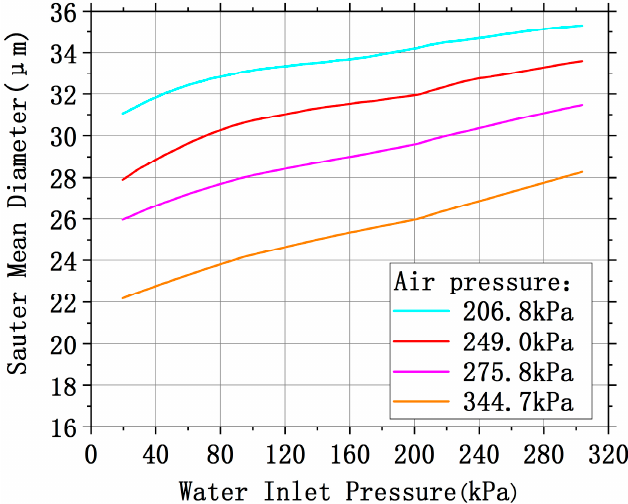
Figure 5. Sauter Mean Diameter (SMD) for water-inlet-pressure (WIP) and Air-inlet-pressure (AIP). Table 1. Fundamental hydrodynamic properties of the nozzle employed in the current study.